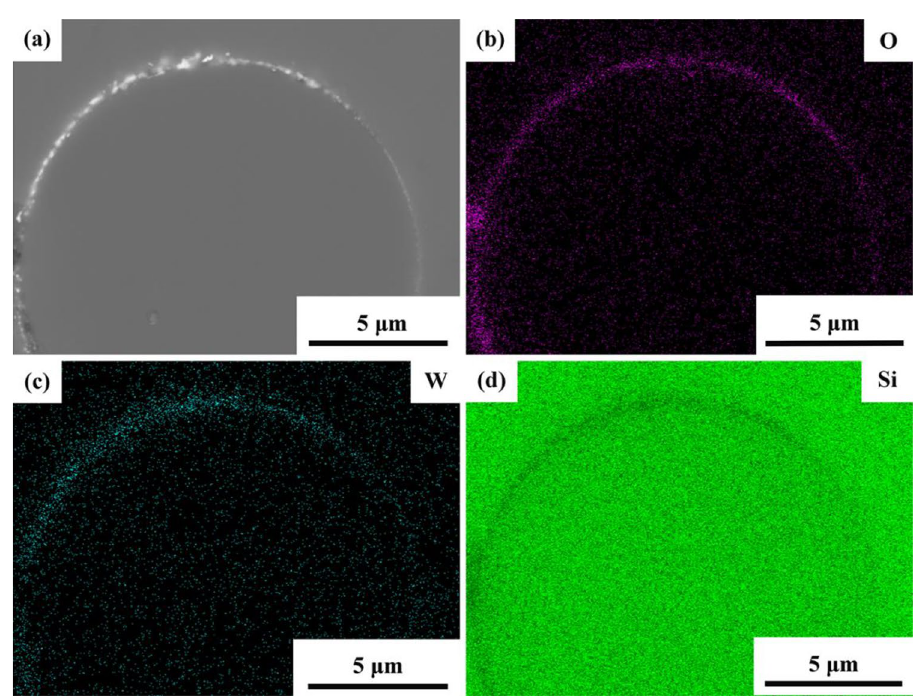
Figure 14. ( a ) Cross-section view of SiC f /CaWO 4 /SiC minicomposite heat-treated at 1300 °C for 50 h. ( b – d ) Corresponding EDS map scanning